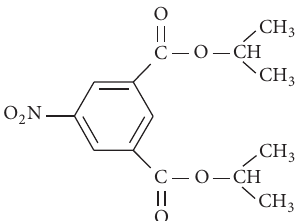
Figure 1: Chemical structure of